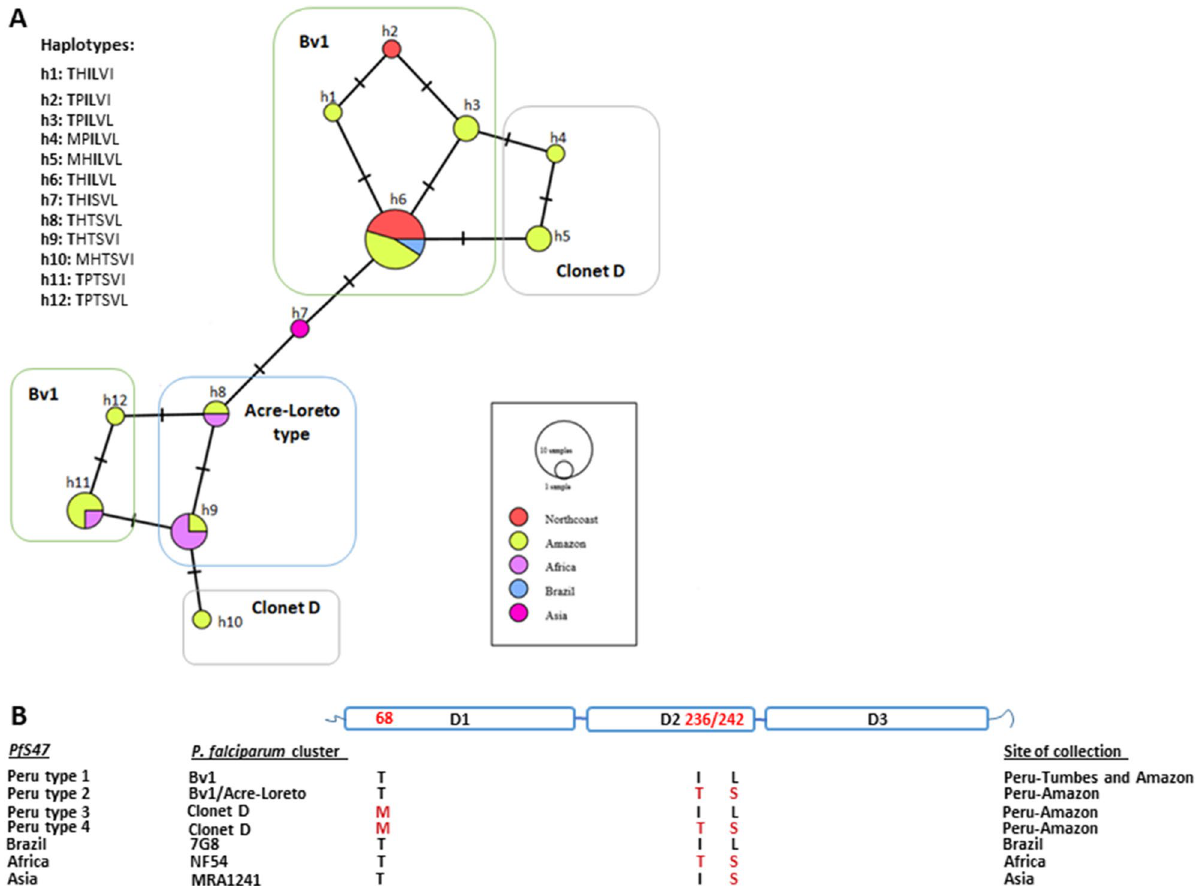
Figure 6. Structural diversity of pfS47 ( A ) Haplotype network for Peruvian isolates and control samples from Brazil, Africa and Asia. The network shows the distribution of the typed Peruvian lineages according to their pfS47 haplotype. ( B ) Four PfS47 circulating haplotypes in Peru based on three amino acid positions associated with evasion to mosquito immune response. D1, D2 and D3 represents protein domains and 68, 236 and 242 amino acid